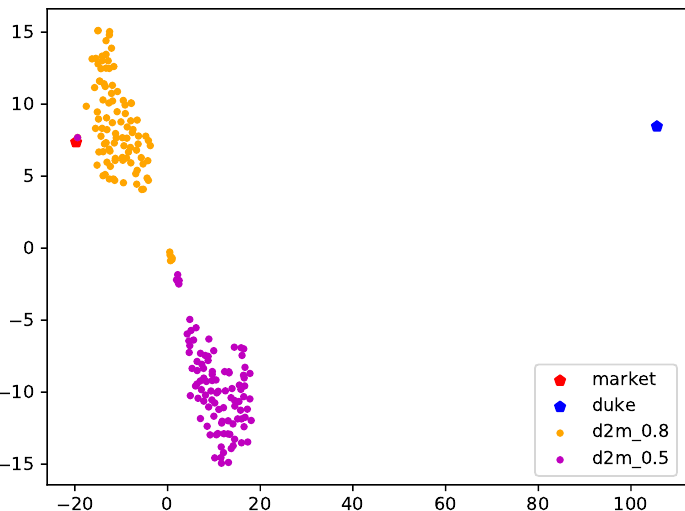
Figure 6. Illustration of data distribution of intermediate domains. The red and blue stars represent the data distribution of Market1501 and DukeMTMC-reID dataset, respectively. d2m_0.5 denotes the features of images generated by GAN, which transfers the style from DukeMTMC-reID to Market1501 for λ =